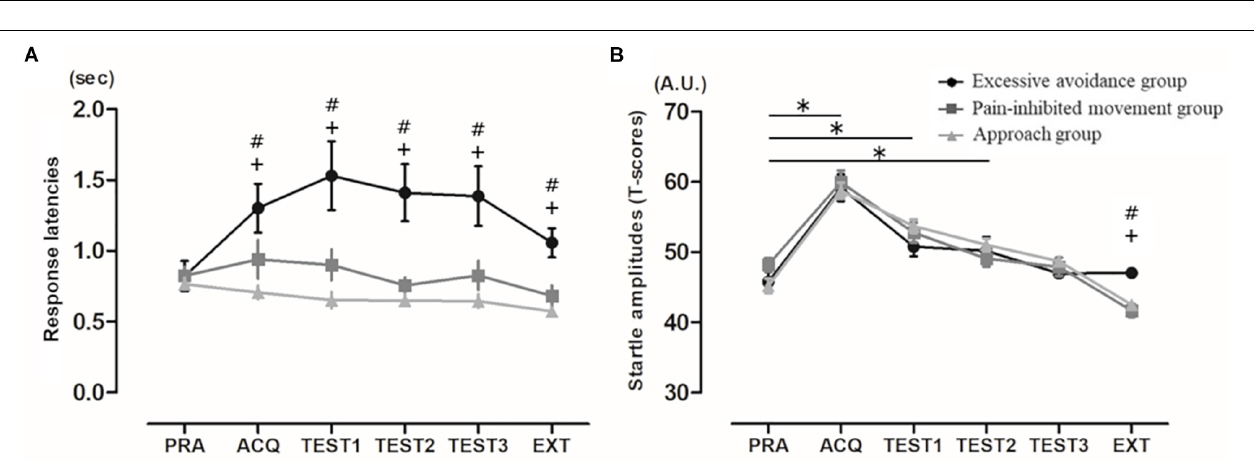
FIGURE 2 | (A) Mean pain-inhibited movement times and (B) mean excessive avoidance times. Average time of specific movement or stopping movement (avoidance from pain) (mean ± SE). ACQ: acquisition phase, TEST1: first set of the test phase, TEST2: second set of the test phase, TEST3: third set. #: significant difference between clusters 1 and 2, +: significant difference between clusters 1 and 3, §: significant difference between clusters 2 and 3 ( p < 0.004).